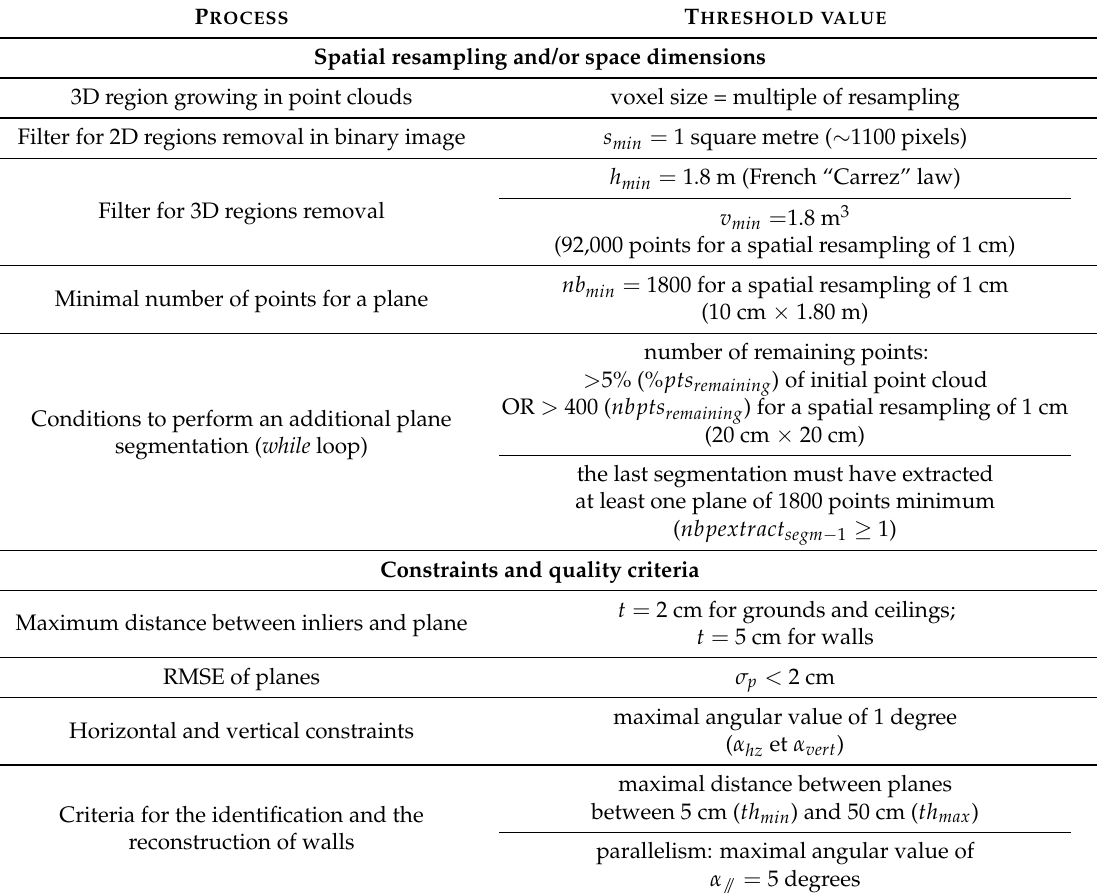
Table 1. Main thresholds involved in the developed approach and default